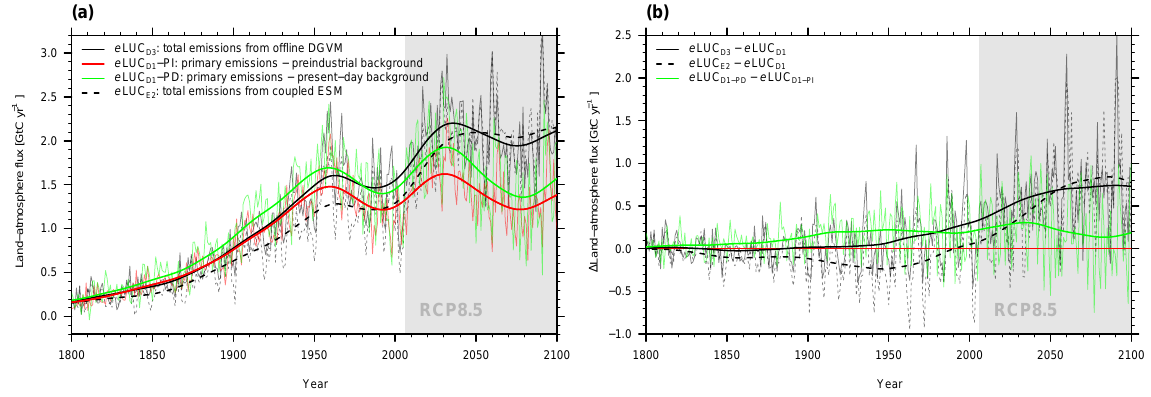
Figure 2. (a) Annual land use change emissions as quantified following different methods. (b) Difference of different e LUC definitions relative to e LUCdI, quantified under preindustrial boundary conditions. Total emissions derived from an offline, concentration-driven DGVM setup (D3 method) are given by black solid lines. Total emissions derived from a coupled, emission-driven ESM setup (E2 method) are given by black dashed lines. Primary emissions are given by coloured lines under constant pre-industrial (red) and constant present-day (green) environmental conditions (climate, CO 2 , N deposition). Time series are calculated following Eqs. (2)–(4), where F is the global total land- atmosphere CO 2 flux in the respective simulation. Bold lines are splines of annual emissions given by thin lines. Results are from simulations following CMIP5 model inputs (historical until 2005, RCP8.5 until 2099). Table 2. Flux decomposition for model setups described in Table 1. A 0 is land area at the reference state, (cid:49)A is the area of land converted relative to the reference state. (cid:49)f und and (cid:49)f dis are the fluxes on unconverted and converted land induced by environmental change. The underlying driver of environmental change is given by the superscripts. f 0 is the flux due to direct impacts of land conversion, not including effects of environmental change. F 0 is zero except for the flux arising from unforced climate variability. The component flux A 0 (cid:49)f LUC 0 has not been named explicitly. Synergy terms are ignored in this table. Note that fluxes F generally refer to global totals for a given point in A 0 ( x,y ) (cid:49)f FF time t . Thus, for example F FF ( t ) = R ( x,y,t )d x d y . For simplicity, we have dropped the time and space dimensions. 0 und x,y Setup Decomposed flux Component